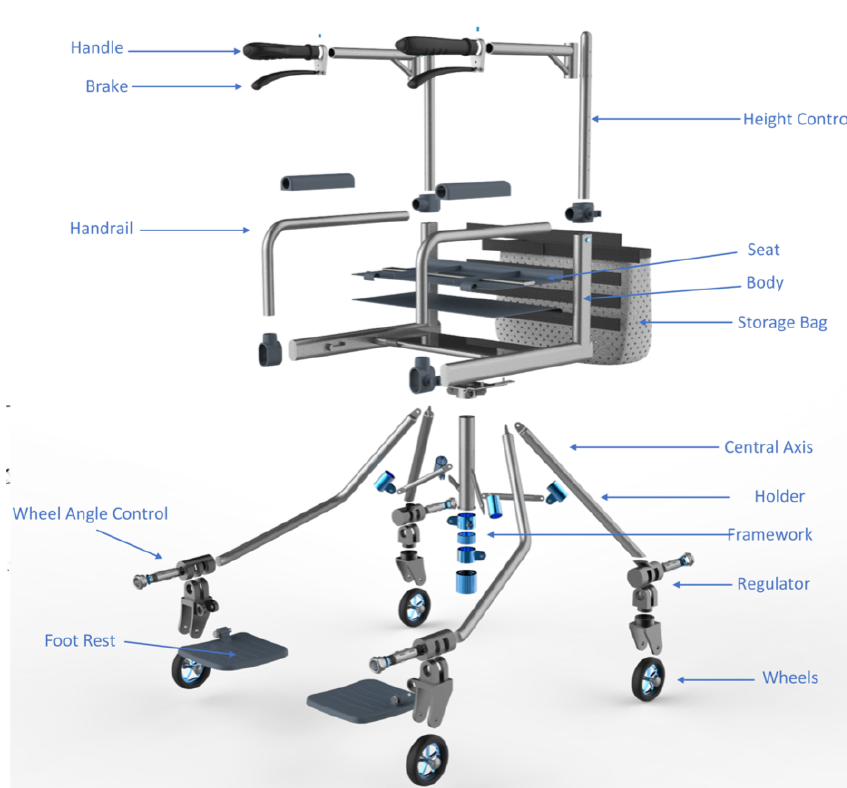
Figure 4. Novel design of four-wheeled